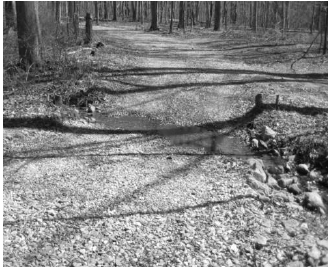
Figure 3. Ford crossing with BMP+ treatment, including rocked running surface and Geo-Web in the channel.